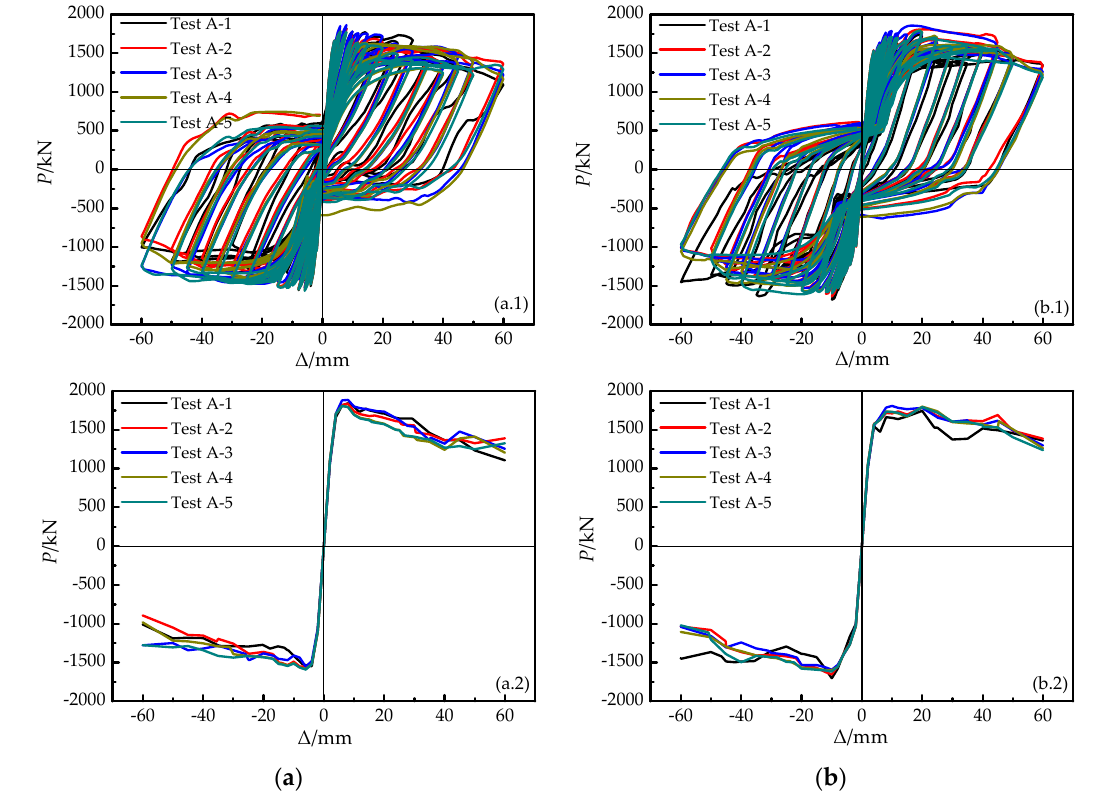
Figure 6. Hysteretic curves and skeleton curves of different layer divisions: ( a ) Node8; ( b ) Node18.